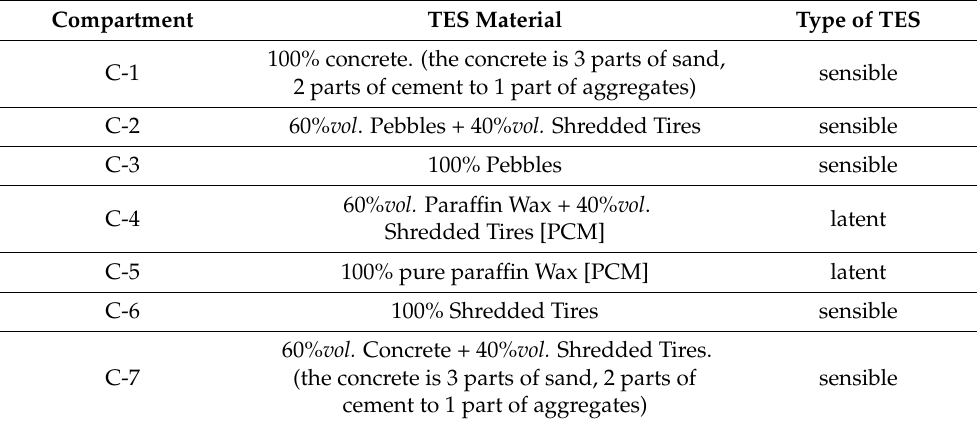
Table 1. Investigated base and composite TES materials with the compartment coding in the test facility.